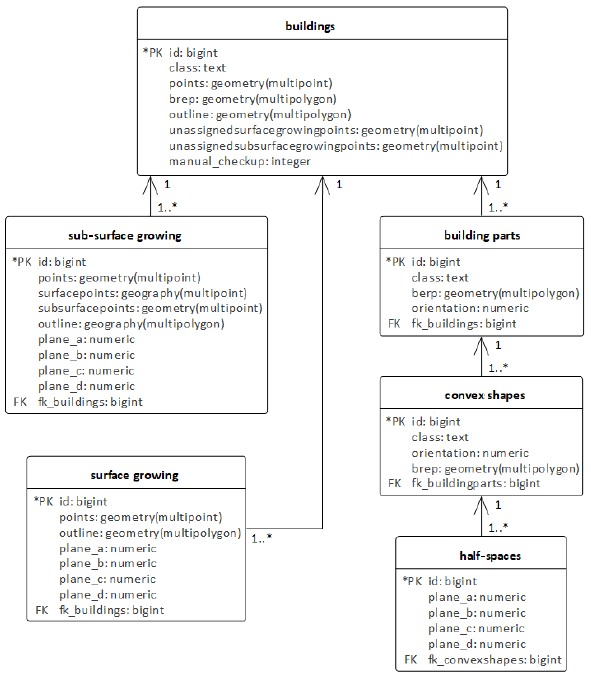
Figure 5. The architecture of RoofN3D and the provided information about a